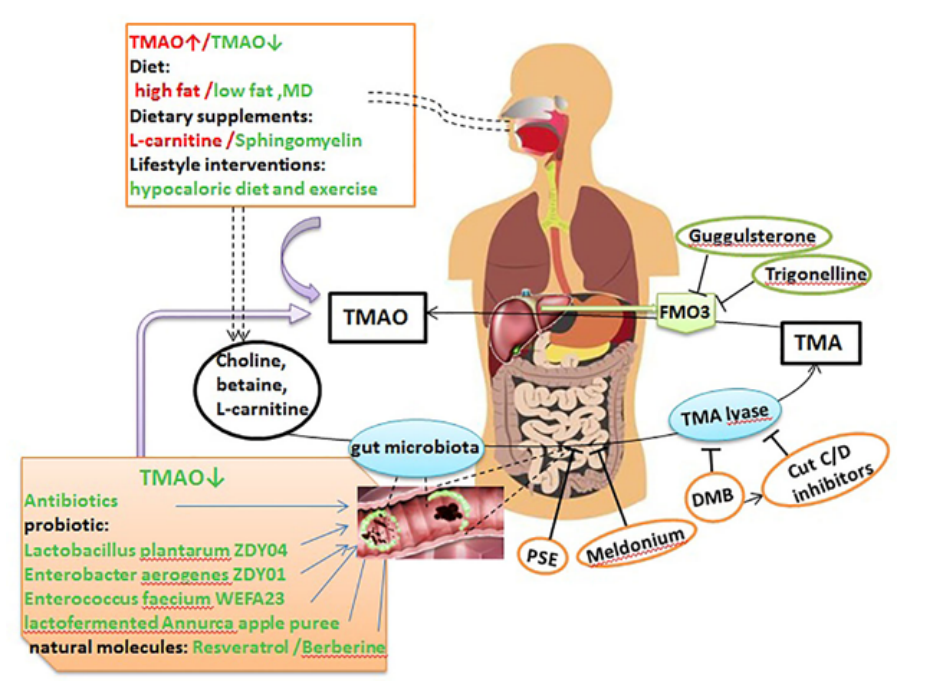
Figure A2. TMAO potential as a therapeutic target in atherosclerosis. This figure is adapted with permission from: 2019 Yang S, et al. [84].